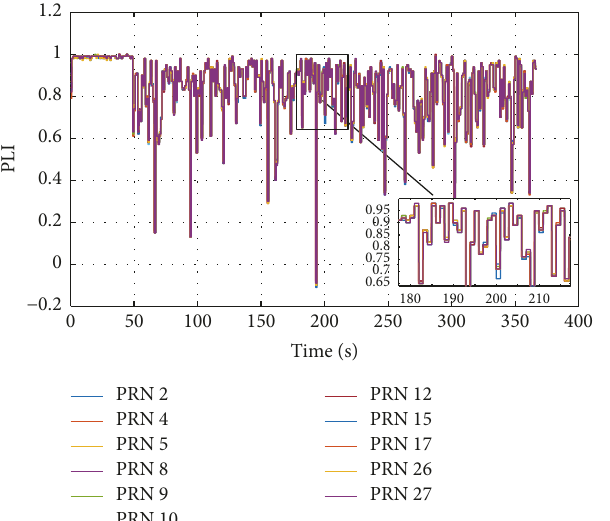
Figure 8: Single difference of carrier phase between 47 dB-Hz and 21 dB-Hz data sets with the joint VPLL.